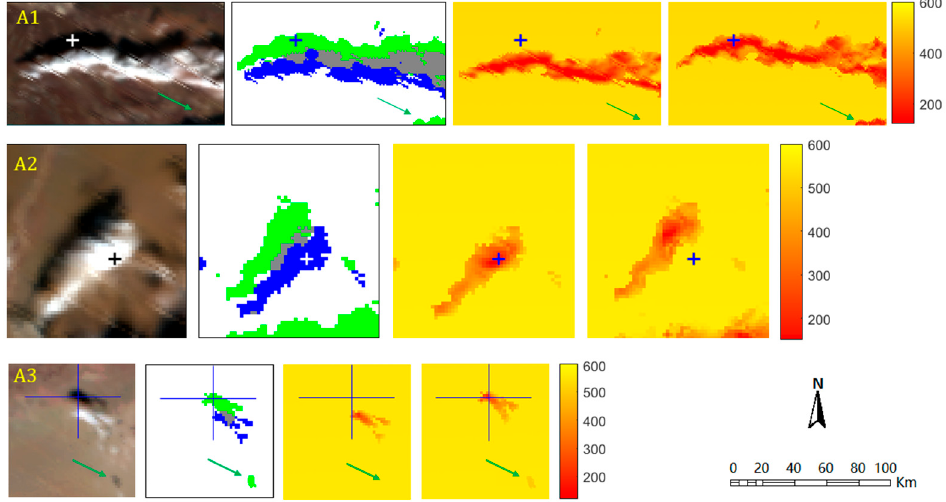
Figure 5. Correction performance of the proposed scheme for three enlarged subset images shown in Figure 3 (please see regions of A1, A2 and A3). (Four columns from left to right: MODIS-L1B RGB image; corrected area for three situations; original SWDR without solar-cloud-sensor geometry correction and the corrected SWDR. The legend is the same as that in Figure 3).